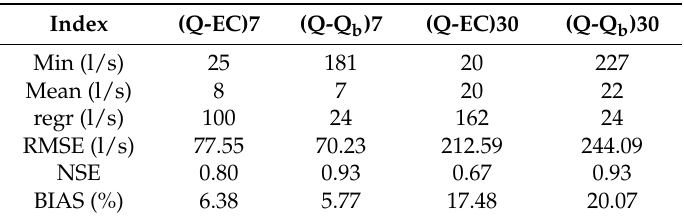
Table 3. Baseflow statistics percentage errors (Min, Mean, and Max) and goodness-of-fit indices for the regression approaches Q-EC and Q-Q b in the case of discontinuous measurements (errors are with regard to the daily scale MBF